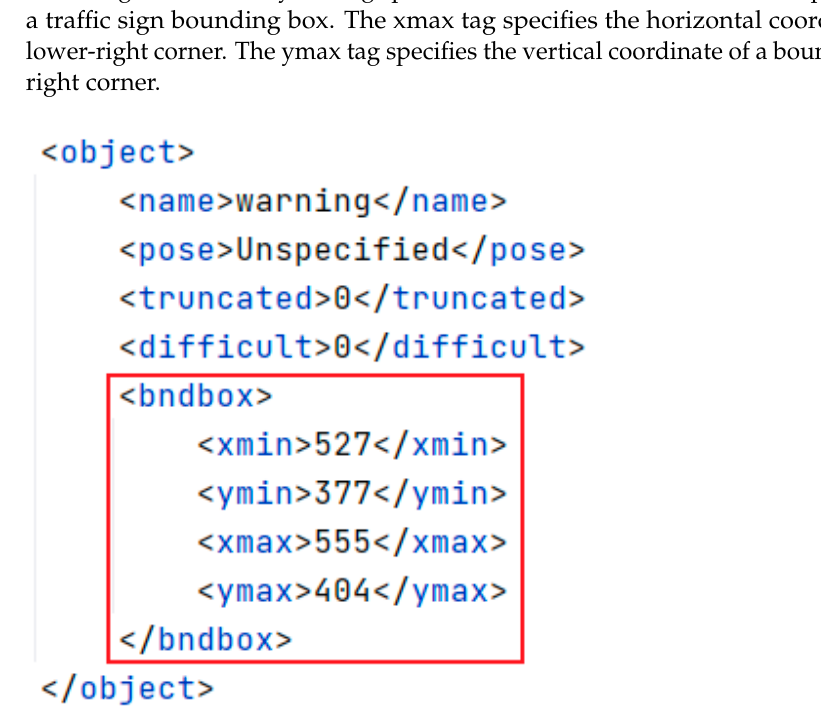
Figure 8. Annotation information of the image.